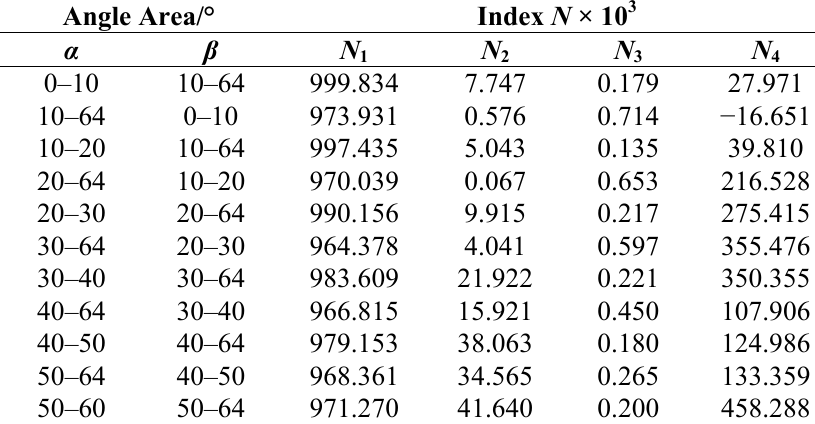
Table 3. Values of index M.